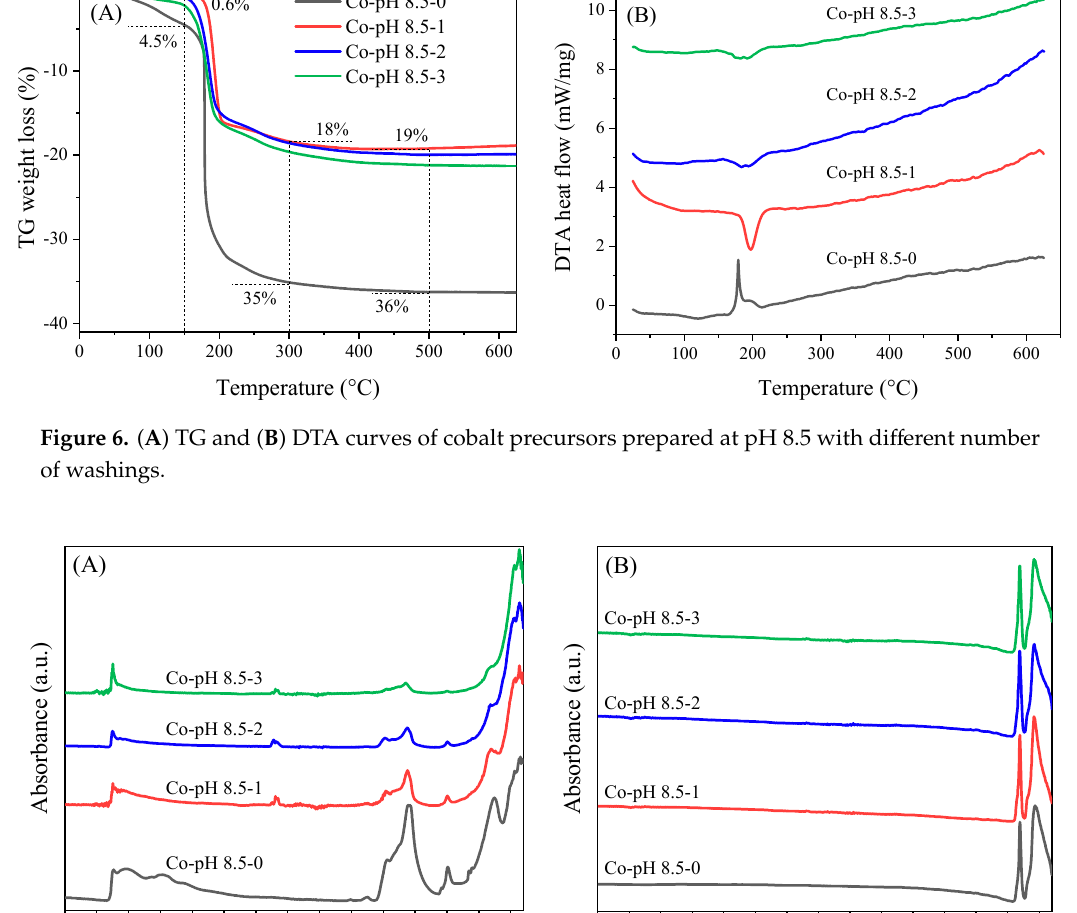
Figure 6. ( A ) TG and ( B ) DTA curves of cobalt precursors prepared at pH 8.5 with different number of washings.